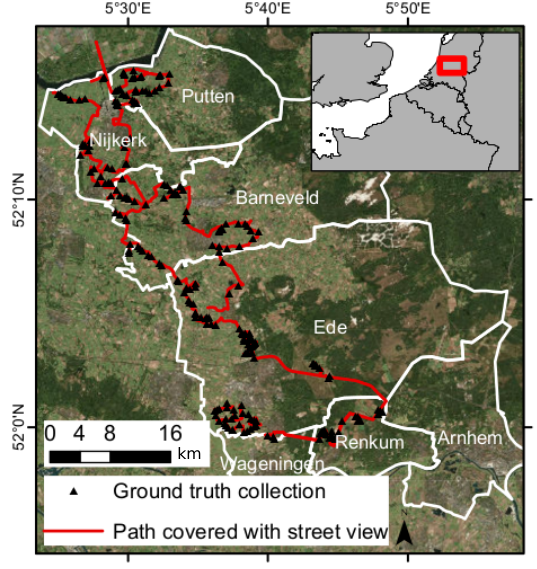
Figure 1. The study site is the Gelderse Vallei including 7 municipalities: Ede, Wageningen, Renkum, Barneveld, Arnhem, Putten and Nijkerk. The ground-truth points were collected during a field visit; geo-tagged street-level imagery was acquired simultaneously at 1 frame per second along the survey